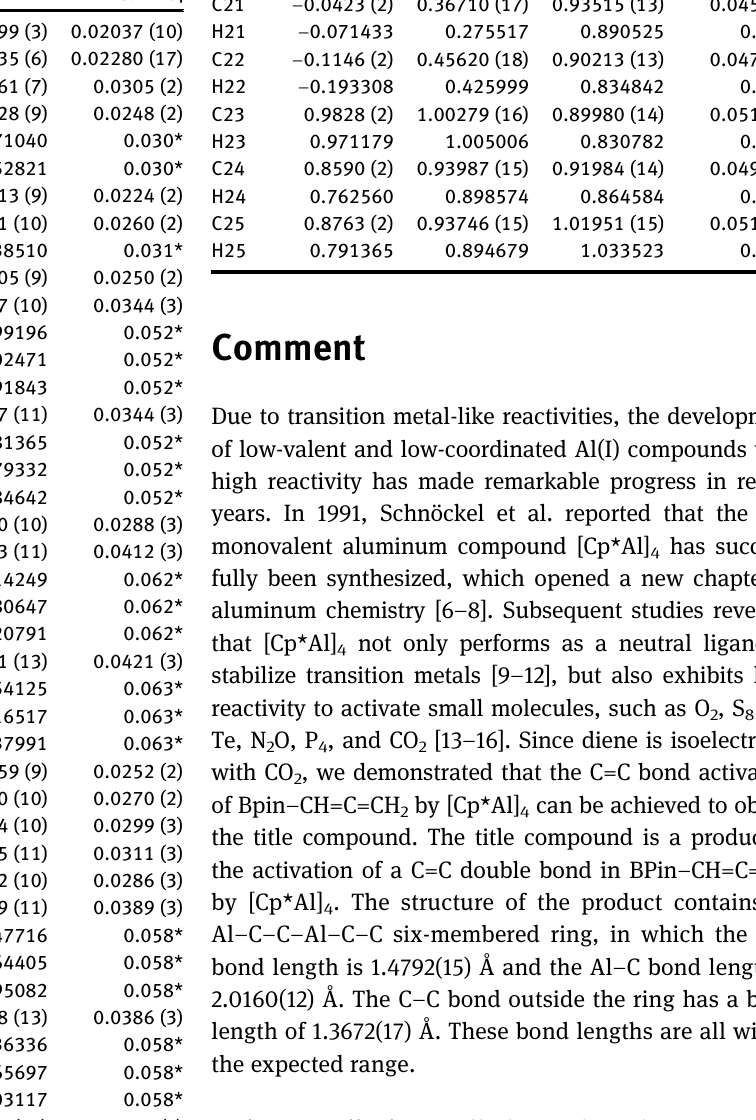
Table  : Fractional atomic coordinates and isotropic or equivalent isotropic displacement parameters (Å  ).